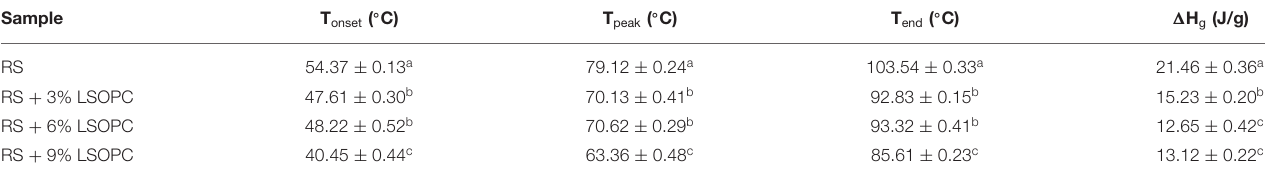
TABLE 1 | Thermodynamic properties of RS with or without